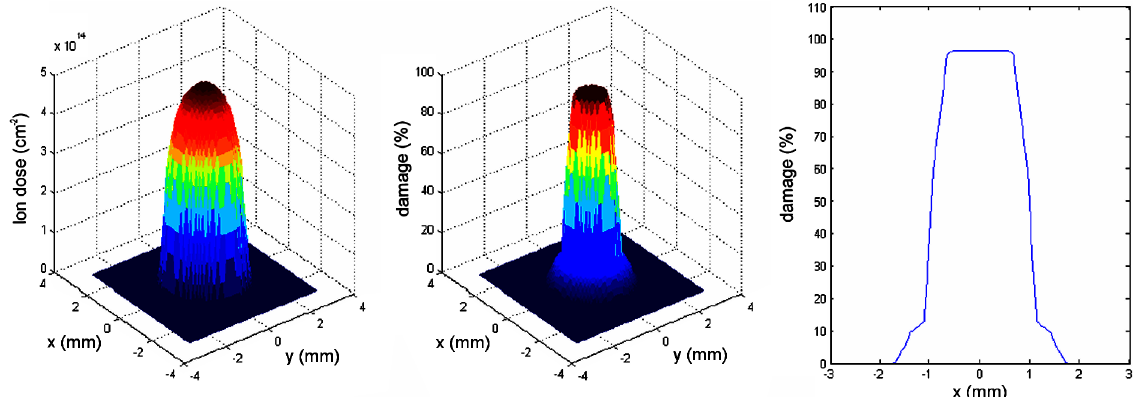
FIG. 13. Left: The 2D dose distribution of ions, calculated from the simulated electron beam profile at the DC gun anode. Middle: The damage profile, or percent amorphization of the Si using the ion beam profile and a superlinear model. Right: a cross section of the damage